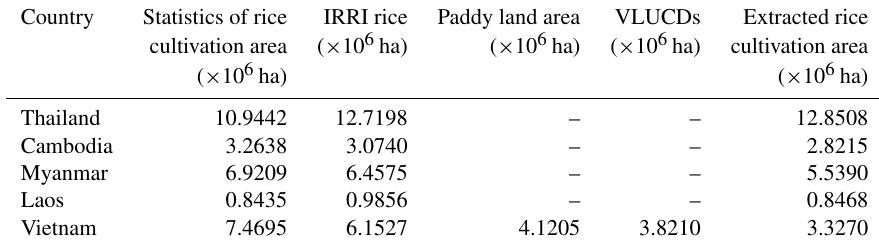
Table 5. Statistics, other rice area maps and the extracted rice area for five Southeast Asian countries. Country Statistics of rice IRRI rice Paddy land area VLUCDs Extracted rice cultivation